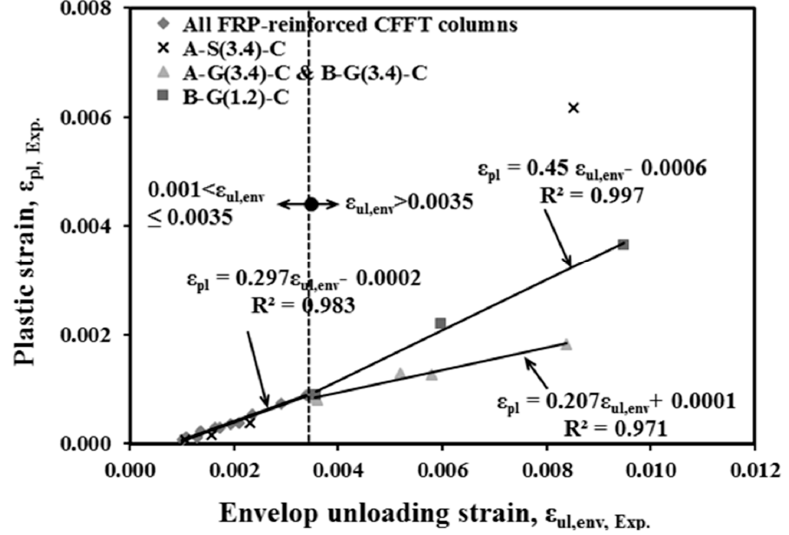
Figure 11. Plastic strain versus envelop unloading strain relationships of test specimens. Table 5. Code predications comparisons versus test results for control (RC) columns.